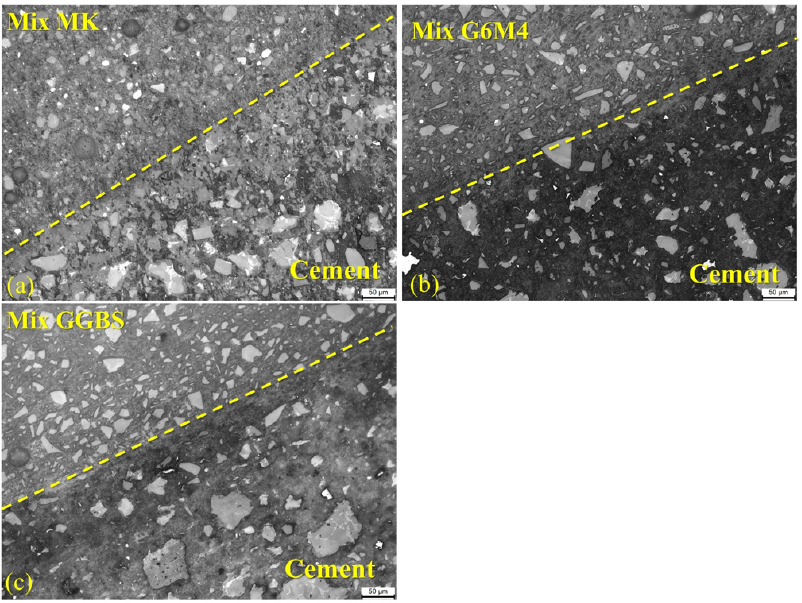
Figure 23. BSE diagram of bonding interface (24 h): ( a ) Mix MK; ( b ) Mix RSM; ( c ) Mix GGBS.